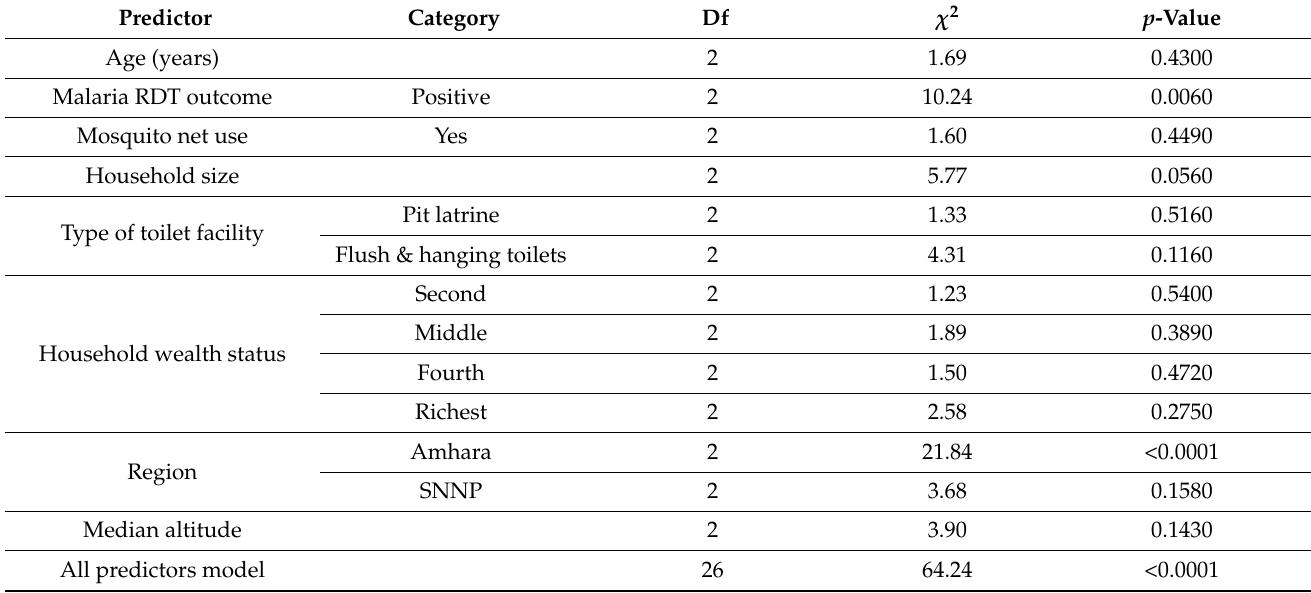
Table 2. The Brant test of parallel regression assumption results for fitted initial main effects cumula- tive logit model for anaemia data.